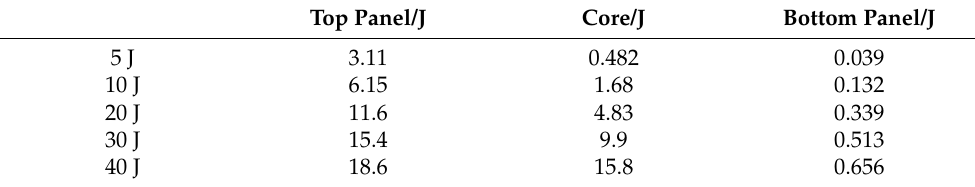
Table 6. Energy absorption of each component of single-layer structure with different impact energies. Top Panel/J Core/J Bottom Panel/J